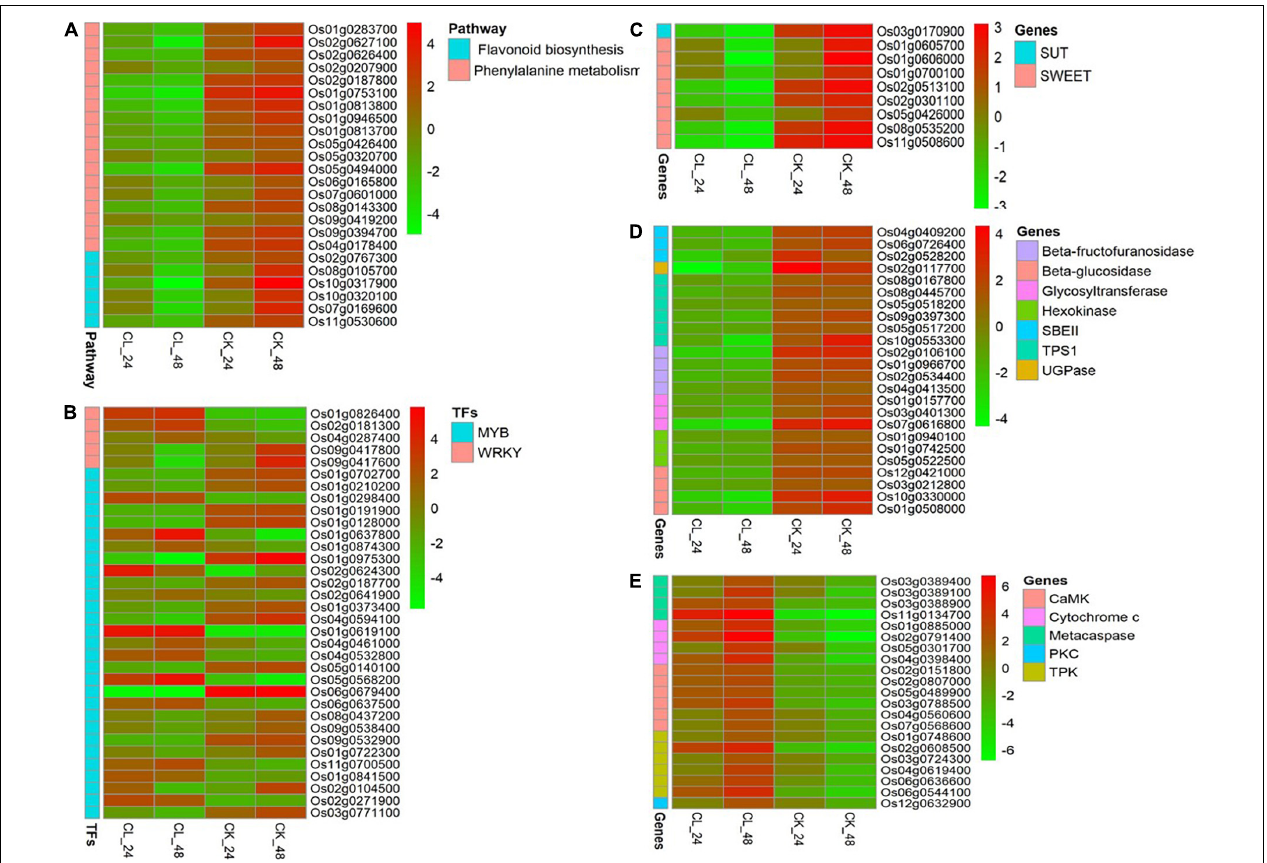
FIGURE 5 | Expression pattern of differentially regulated genes in CL and CK at 24 and 48 h, respectively. (A) Phenylpropanoid biosynthesis and flavonoid biosynthesis pathways. (B) WRKY and v-myb avian myeloblastosis viral oncogene homolog (MYB) genes. (C) Sugar transporter genes. (D) Starch synthesis-related genes. (E) PCD-related regulatory